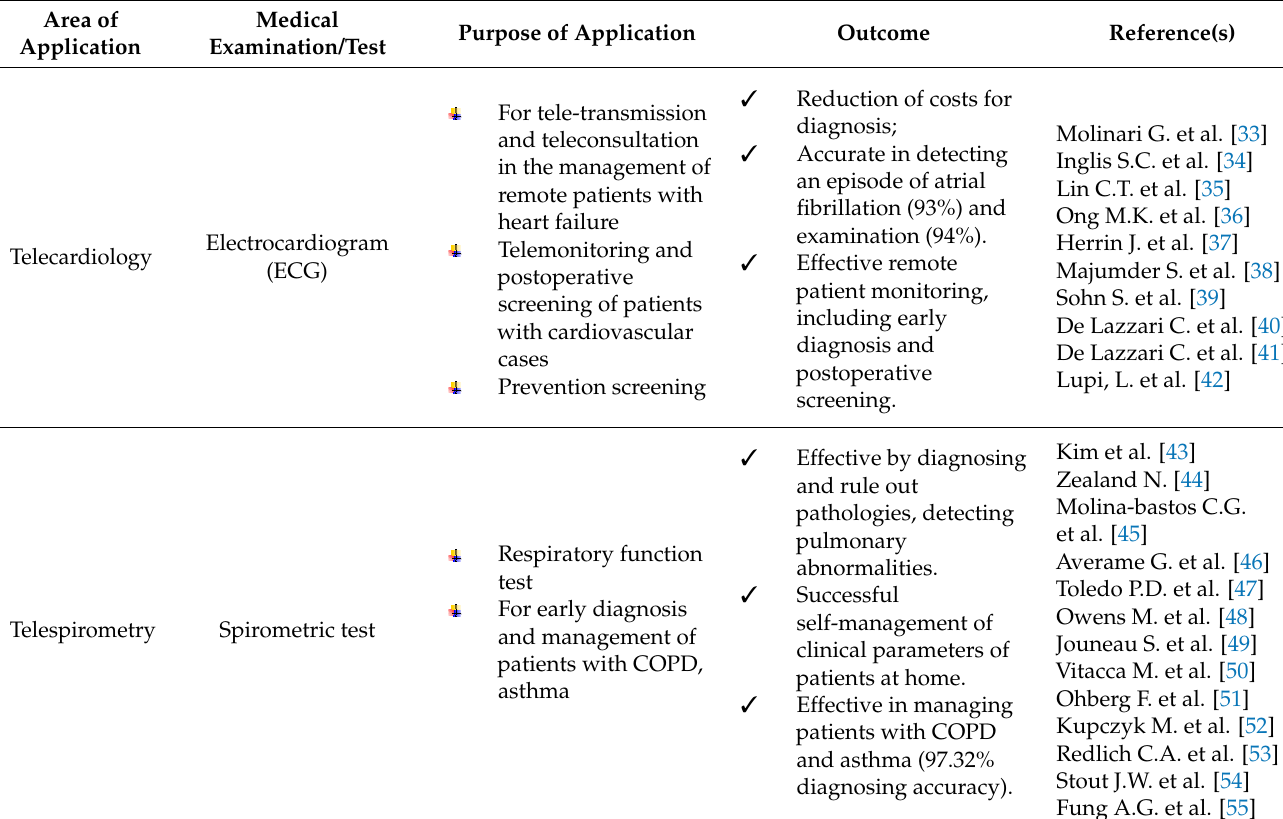
Table 1. Summary of results for the application of telemedicine in different medical examinations/tests. Figure 1. Literature search flowchart with eligibility criteria.